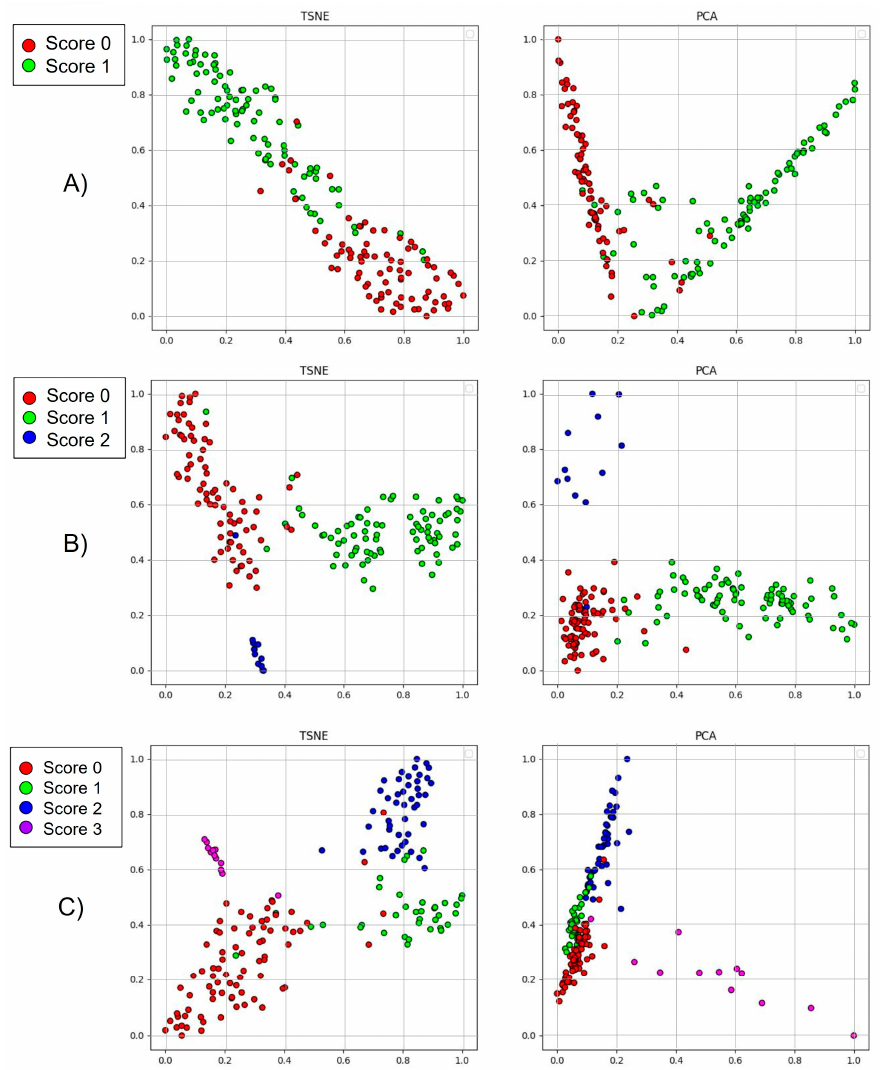
Figure 4. t-SNE and PCA results: ( A ) binary classification, ( B ) three-way classification, and ( C ) four- way classification.